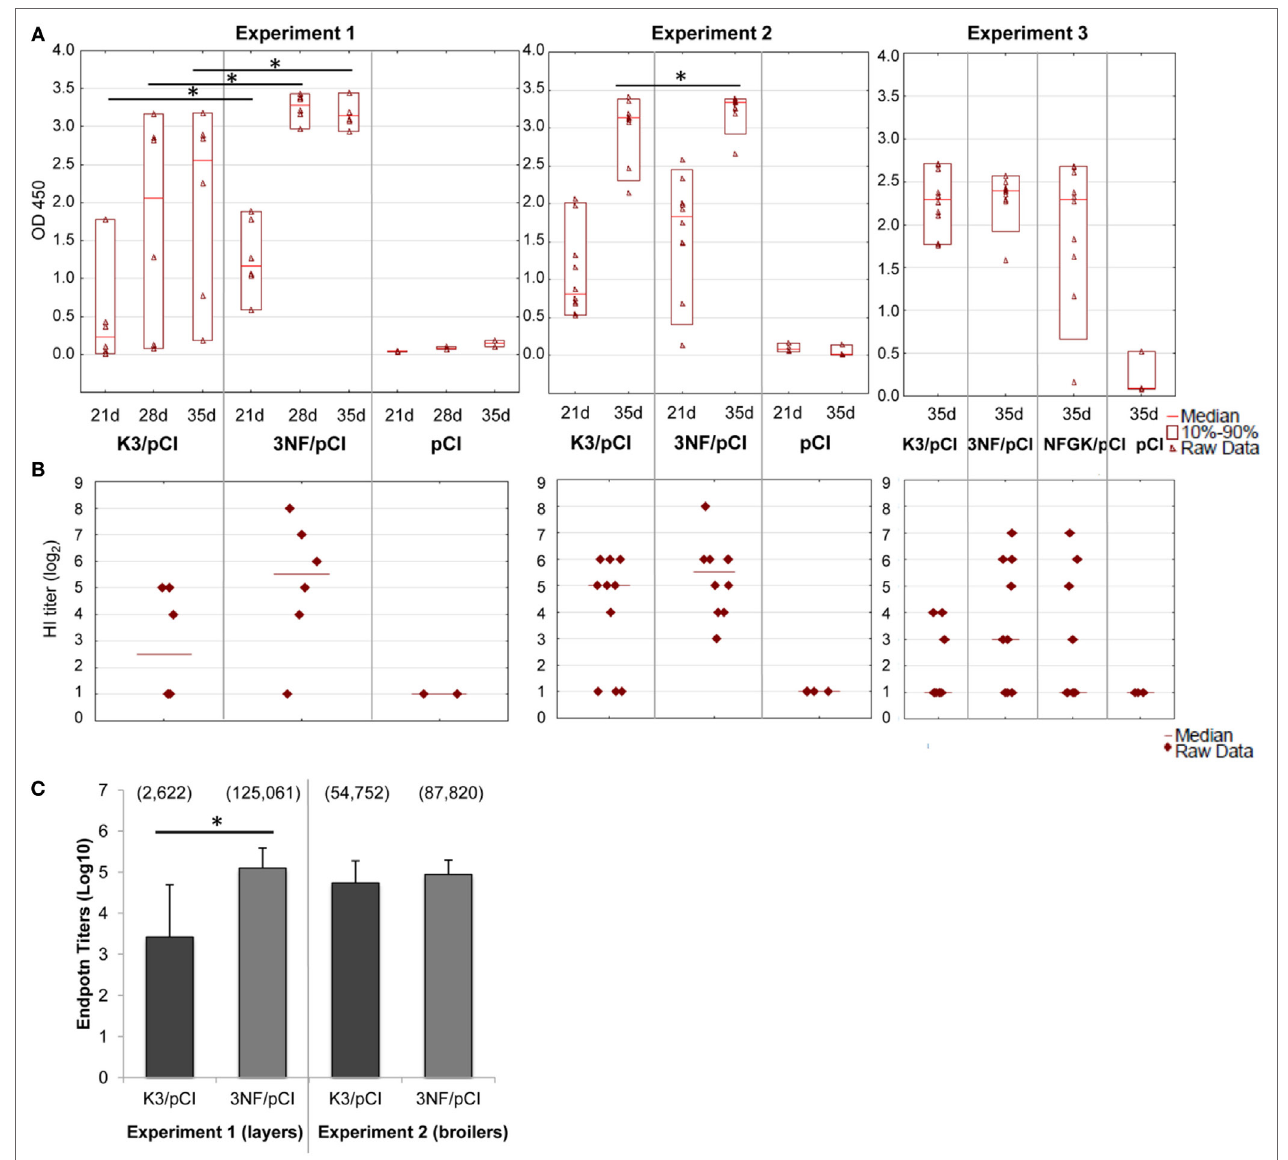
FigUre 1 | Humoral response of chickens to the tested variants of the DNA vaccine. (a) The results of the one-dilution ELISA test shown for individuals with medians and the 10th and 90th percentiles indicated for each group. All sera were diluted 200-fold. Statistically significant differences ( p < 0.05) are marked by asterisks. (B) The individual HI titers and medians in each group (only for day 35) are shown as log 2 . Sera with undetected antibody levels were given an arbitrary value of 1. (c) The endpoint titers of anti-H5 hemagglutinin antibodies (day 35) of each group from Experiments 1 and 2. Data are presented as mean values with SD; geometric means are indicated in the brackets. Statistically significant differences ( p < 0.05) are marked by